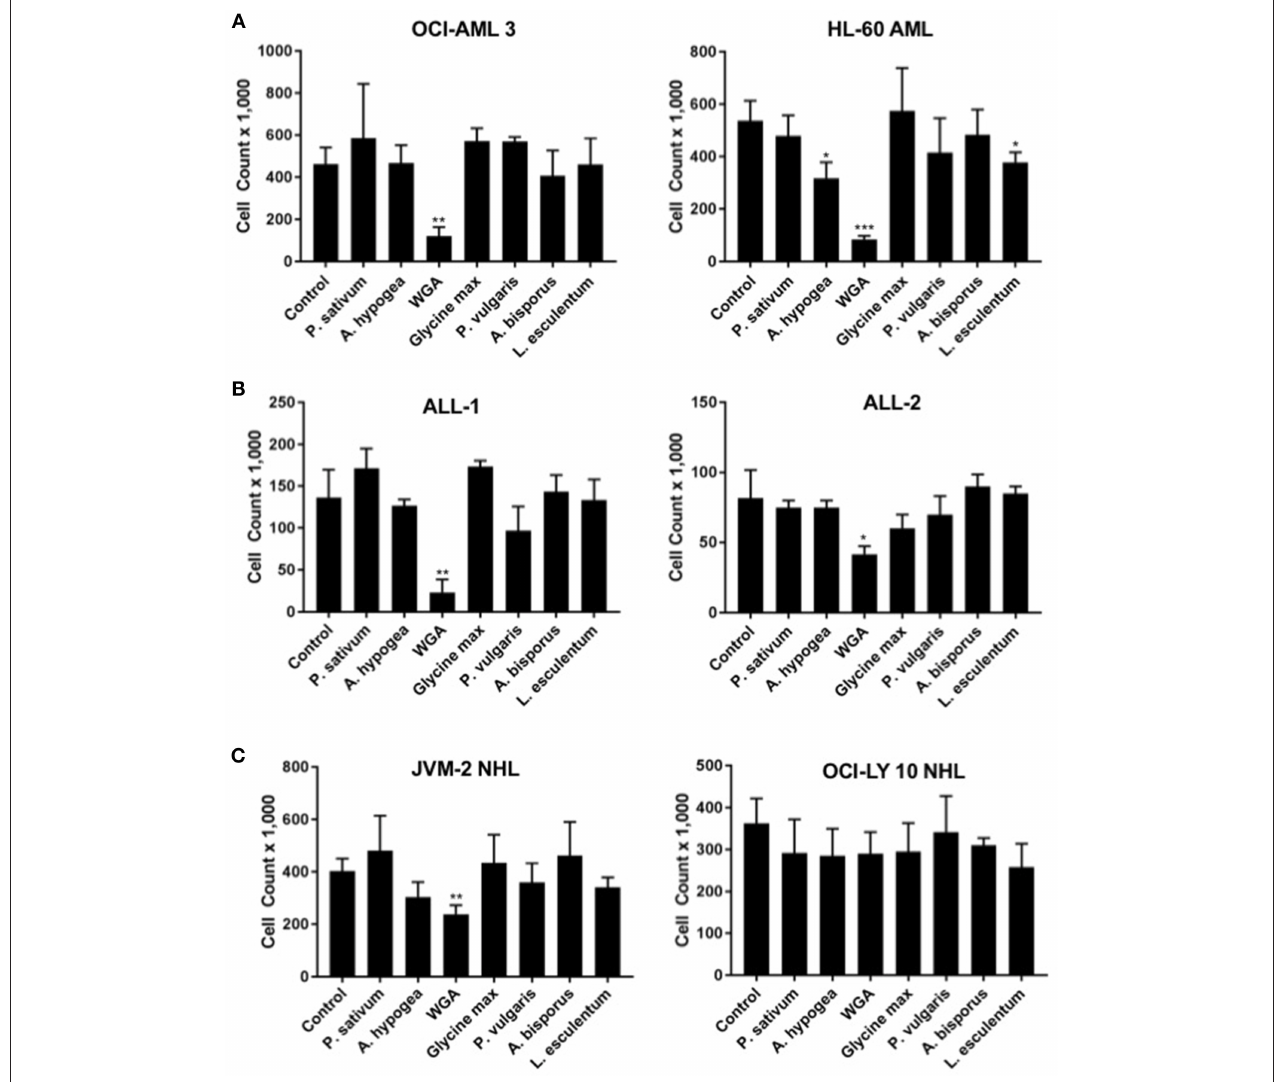
FIGURE 1 | Lectins demonstrate variable toxicities to cancer types. (A) Viable cell count of AML (OCI-AML3 and HL-60) cells treated with different dietary lectins as indicated. (B) Viable cell count of ALL (ALL-1 and ALL-2) cells treated with different dietary lectins as indicated. (C) Viable cell count of NHL (JVM2 and OCI-Ly10) cells treated with different dietary lectins as indicated. All seven lectins administered at 2 µ g/mL for 24h for all cell types. Un-labeled bars were non-significant compared to control. * p < 0.05, ** p < 0.01, *** p < 0.001, and ns >